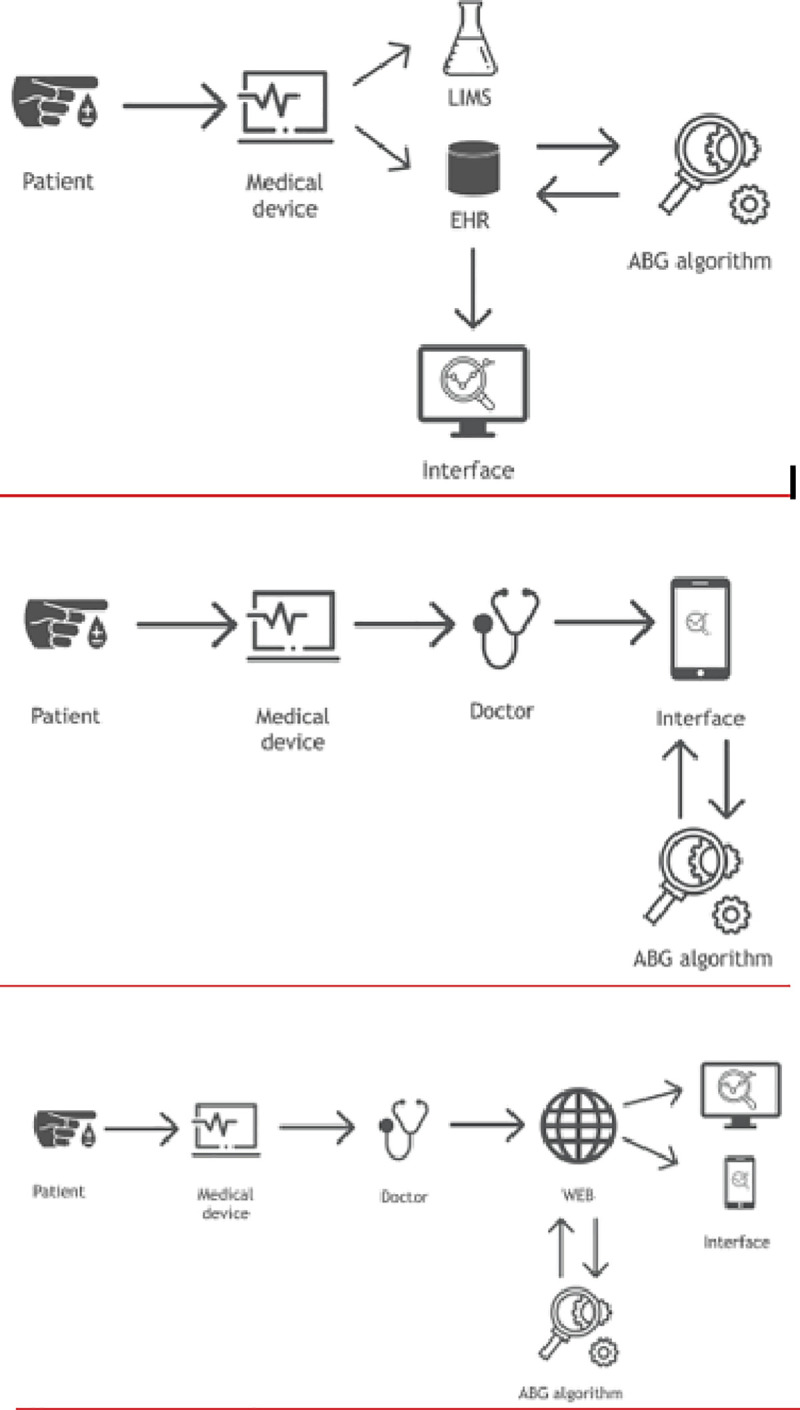
Connectivity.The communication and integration of the results with the hospital information system and other devices, can also be through the cloud and interface.